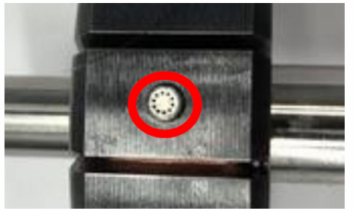
Figure 13. Pressure transducer glued into the rotor of the BVP to record the instantaneous pressure profile in a displacement